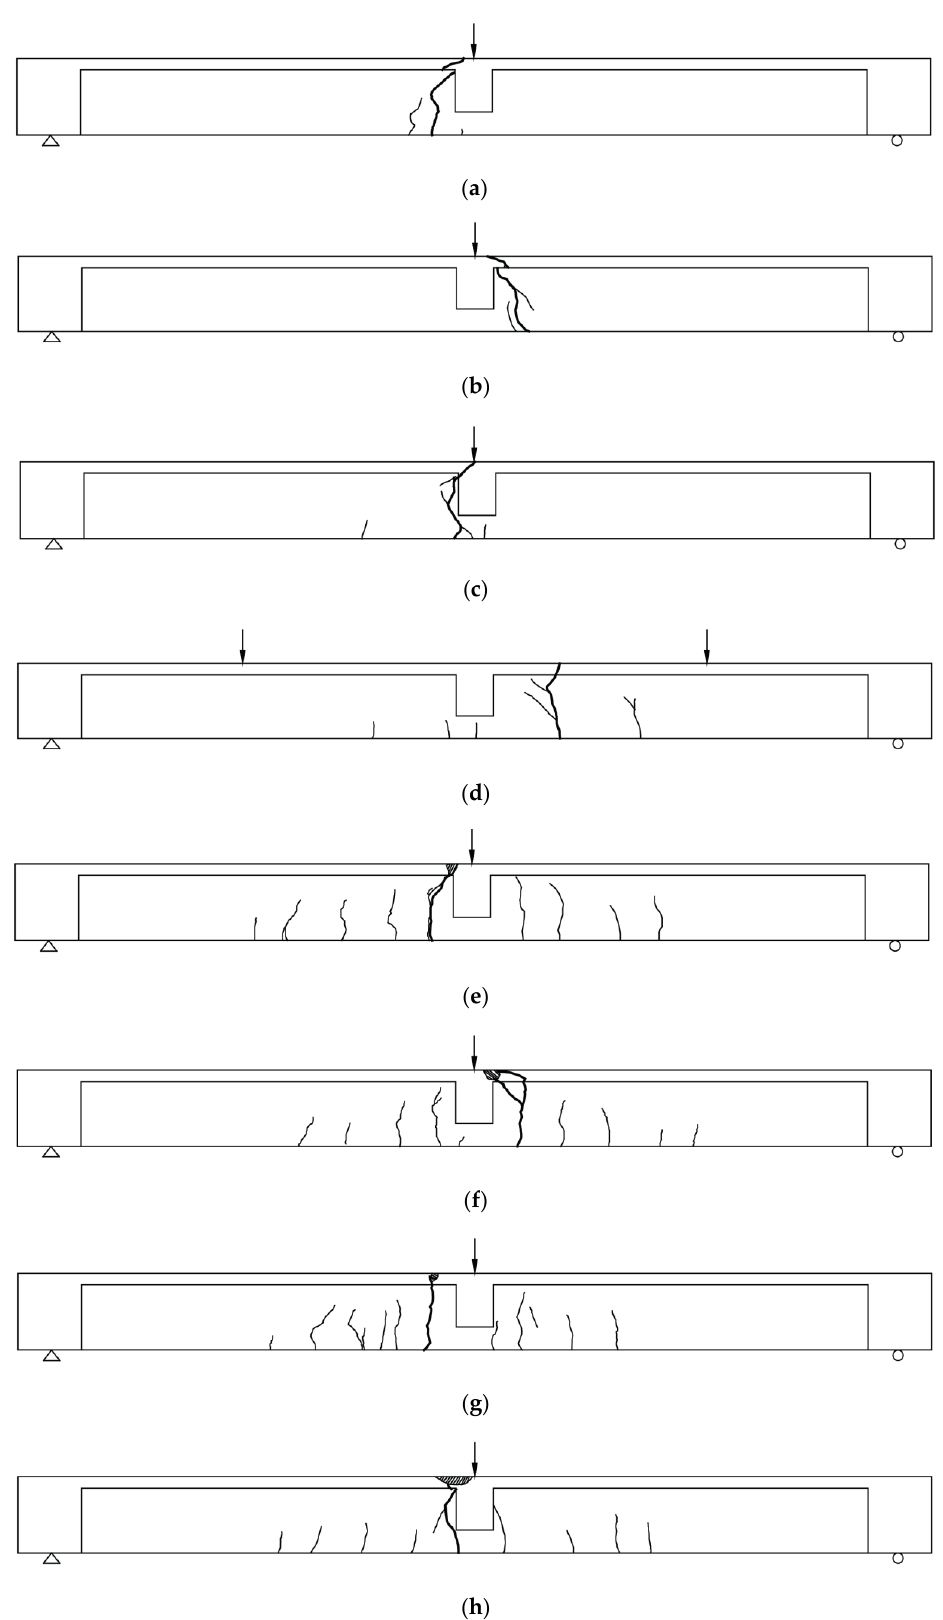
Figure 8. Cracking patterns of specimens: ( a ) E30-P100-D0-L3; ( b ) E45-P100-D0-L3; ( c ) E55-P100-D0-L3; ( d ) E45-P100-D0-L4; ( e ) E30-P85-D0-L3; ( f ) E30-P85-D3-L3; ( g ) E30-P85-D6-L3; ( h ) E55-P68-D0-L3.